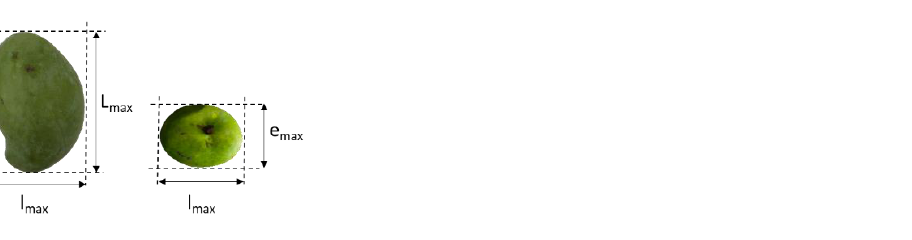
Figure 1. Digital photo of the three dimensions (L max ,l max and e max ) of mango.